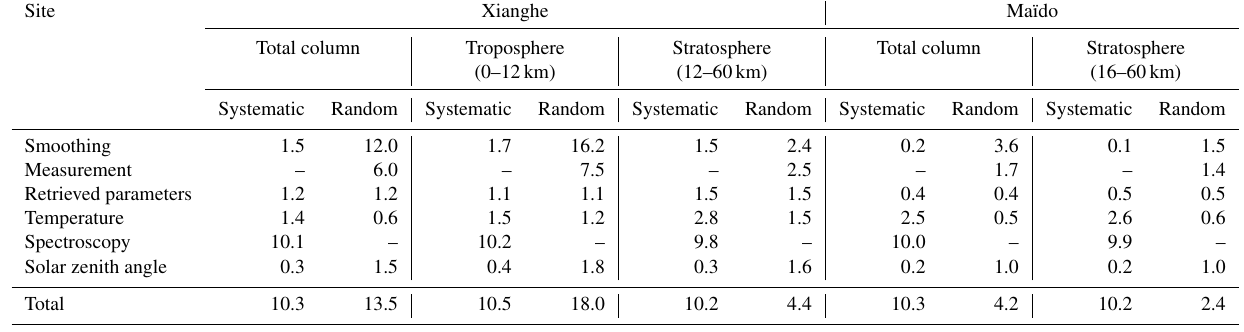
Table 2. The retrieval uncertainties in the NO total and partial columns at Xianghe and Maïdo. All uncertainties are in percent (%). Site